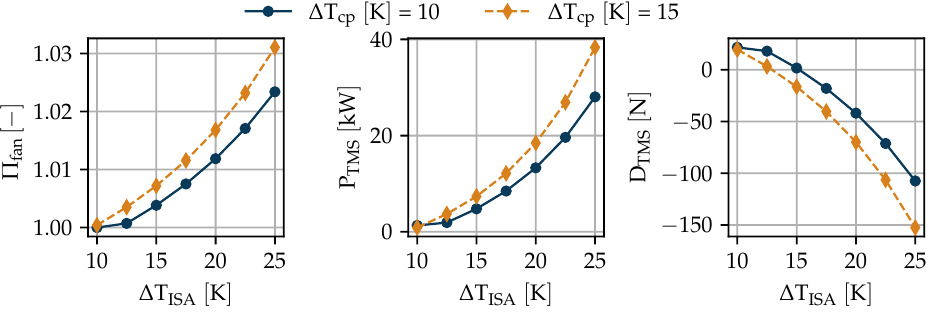
Figure 11. Off-design optimization at takeoff for a TMS designed for T cp , des = 380 K and S P = 30%. Hot days are a particular challenge for the TMS because the available ∆ T between cooling fluid and ambient is smaller. Raising ∆ T ISA results in an exponential increase in required fan pressure ratio ( Π fan ). ∆ T cp is an operational parameter that can be controlled via P pump . A lower P pump results in a smaller w h , and thereby a higher ∆ T cp . A higher ∆ T